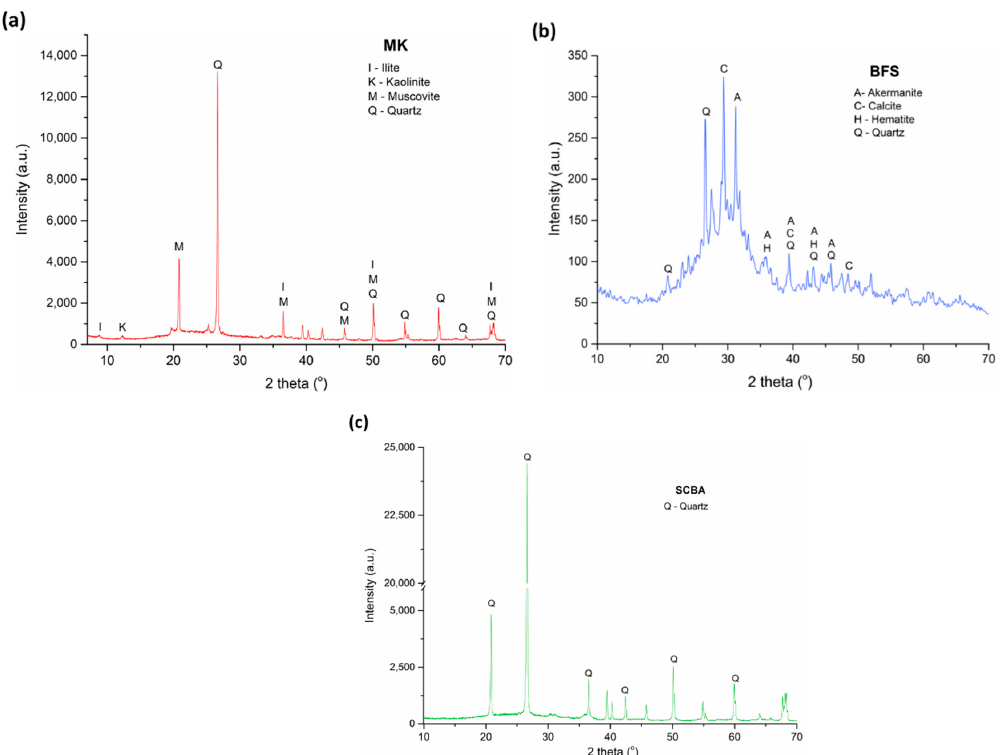
Figure 11. XRD patterns of precursors ( a ) BFS, ( b ) MK and ( c ) SCBA. The FTIR spectra of the precursors (Figure 12) identified wave numbers between 2000 and 400 cm − 1 . The main peak is located in the region of 900–1200 cm − 1 and it is associated to Si ‐ OT asymmetrical stretching vibrations (T being Si or Al tetrahedral) [73]. In MK, this peak is around 1030 cm − 1 and is deeper than the peaks in SCBA and BFS, which are located in the 1040 cm − 1 and 910 cm − 1 band, respectively. Moreover, in BFS spectra, a shoulder is signed around 870 cm − 1 , which is associated with Al ‐ O asymmetric stretching [74] present in the vitreous phase [43]. Carbonate traces are identified at 1430 and 710 cm − 1 and are associated with the O ‐ C ‐ O asymmetric elongation mode of the CO 32 − anion group [75]. In MK and SCBA, the band located at 770 cm − 1 is associated with the Al ‐ O elongation vibra ‐ tion, and in the regions of 500–400 cm − 1 with the vibration of the Si ‐ O ‐ Al and Si ‐ O ‐ Si bond [57,70,76] and also with the bending of amorphous silica [26]. The appearance of Si ‐ O bands identified in the SCBA spectrum can be related to the presence of quartz in the material, as also identified by XRD analysis (Figure 11c).